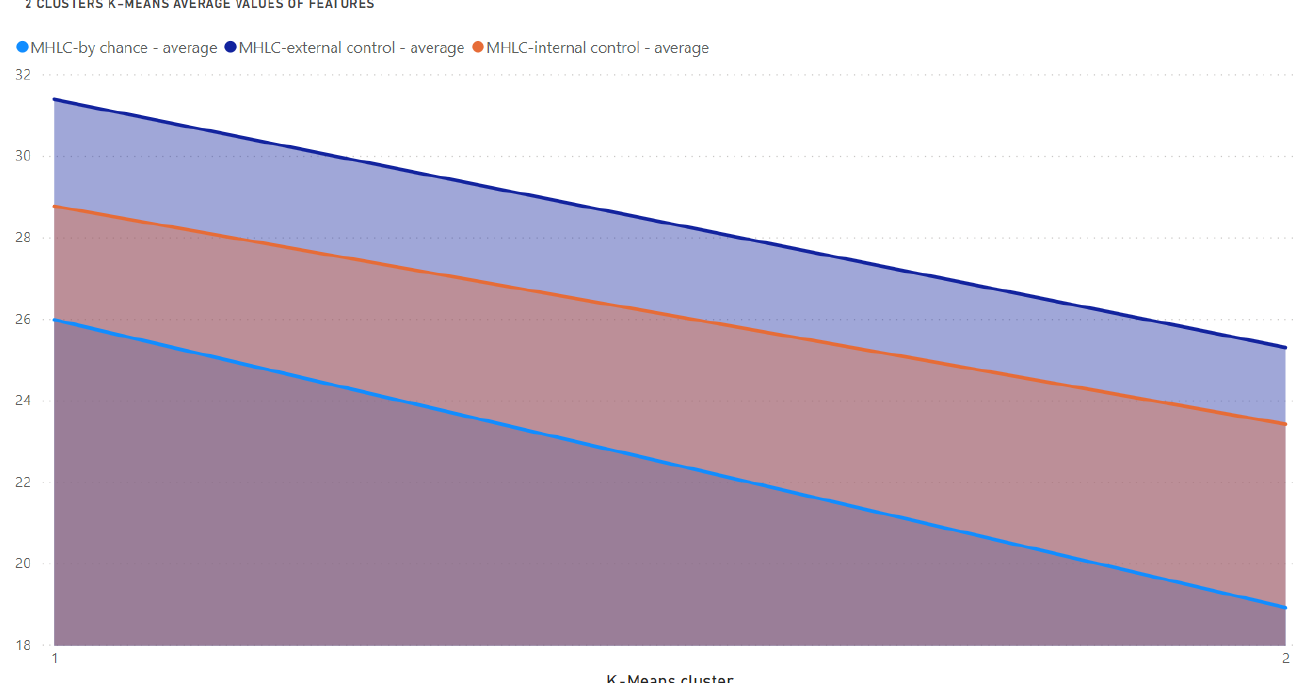
Figure 3. Average values of analyzed features for 2 K-Means clusters.